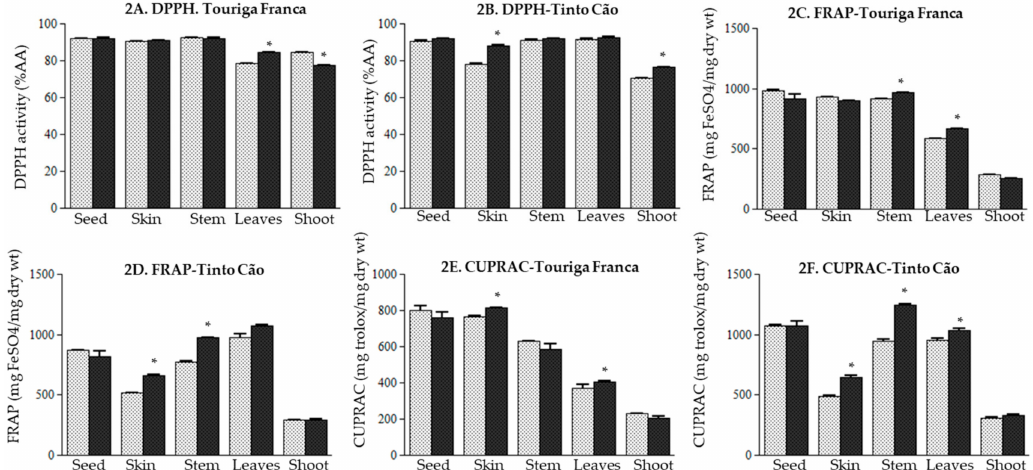
Figure 2. ( A , B ) 2,2-diphenyl-1-picrylhydrazyl activity (DPPH), ( C , D ) Ferric Reducing Antioxidant Power (FRAP), ( E , F ), Copper Reducing Antioxidant Capacity (CUPRAC) in the tissues of grapevine after application of chitosan before and after veraison. Tissues were collected at complete maturation of the berries. Gray column = control samples; black column = chitosan-treated samples. All data were obtained from three biological replicates; standard deviations and the levels of significance ( p < 0.05; t -test) are represented by error bars and asterisks above the columns,